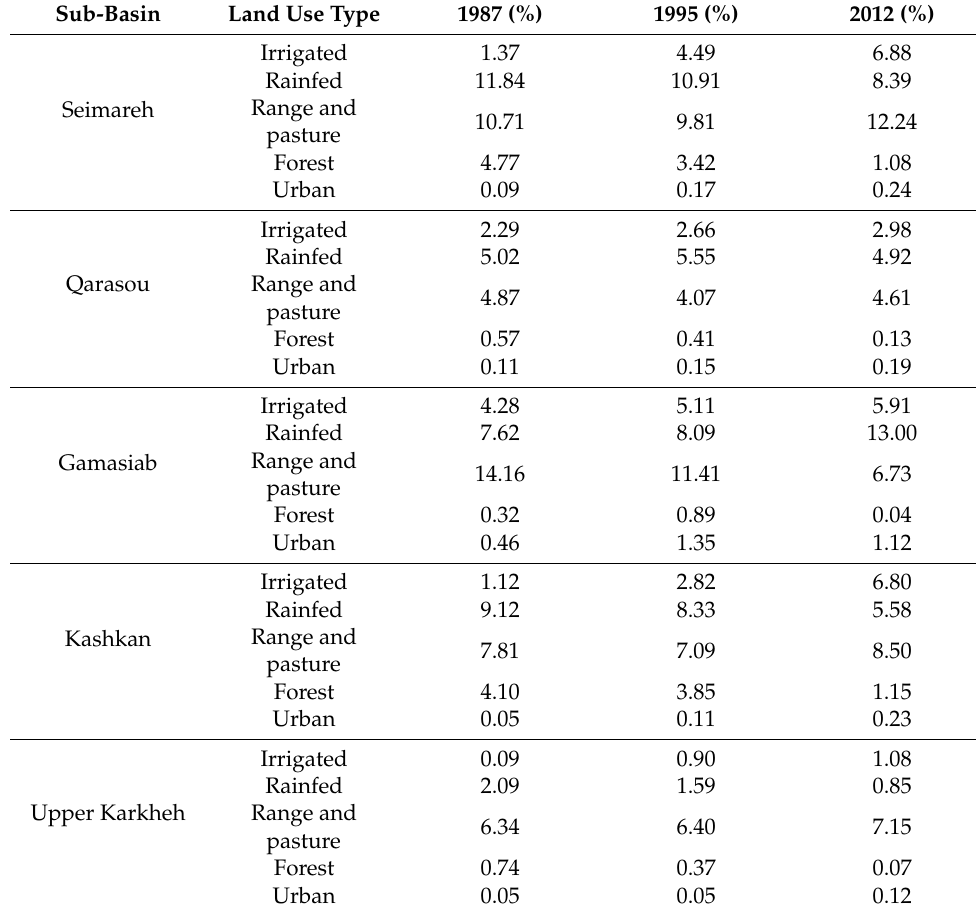
Table 7. Percentage of land use classes in the five studied sub-basins for selected years.